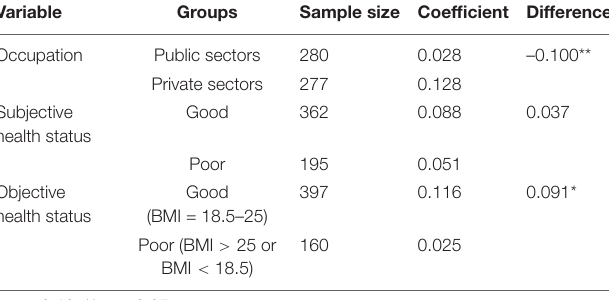
TABLE 5 | Multi-group comparison test results.